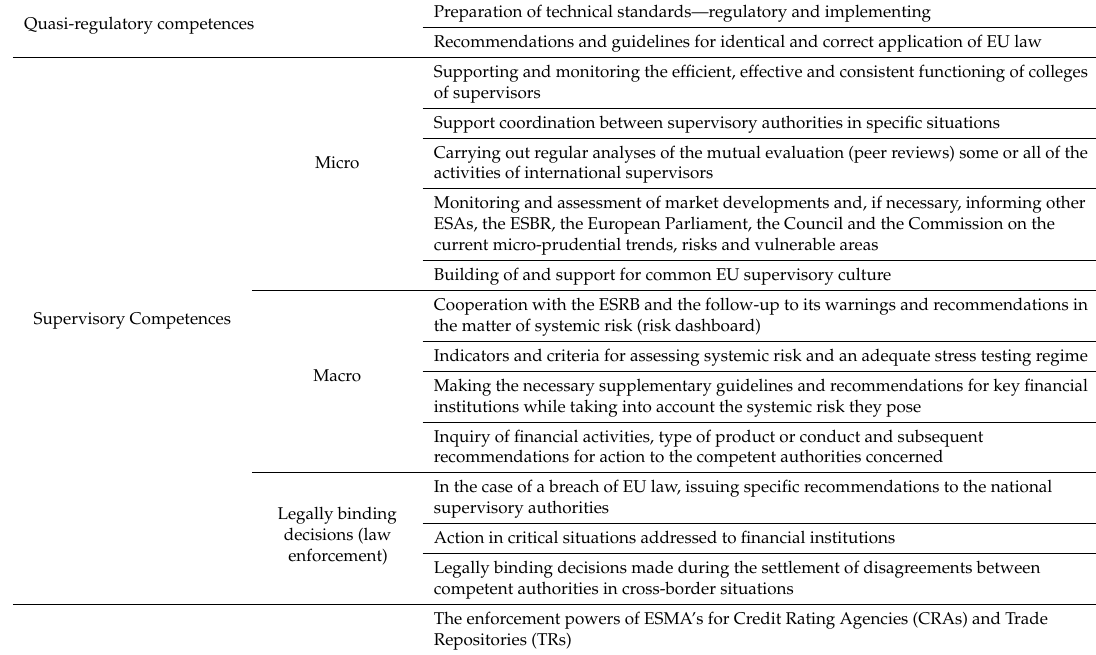
Table 1. Tools and tasks of the